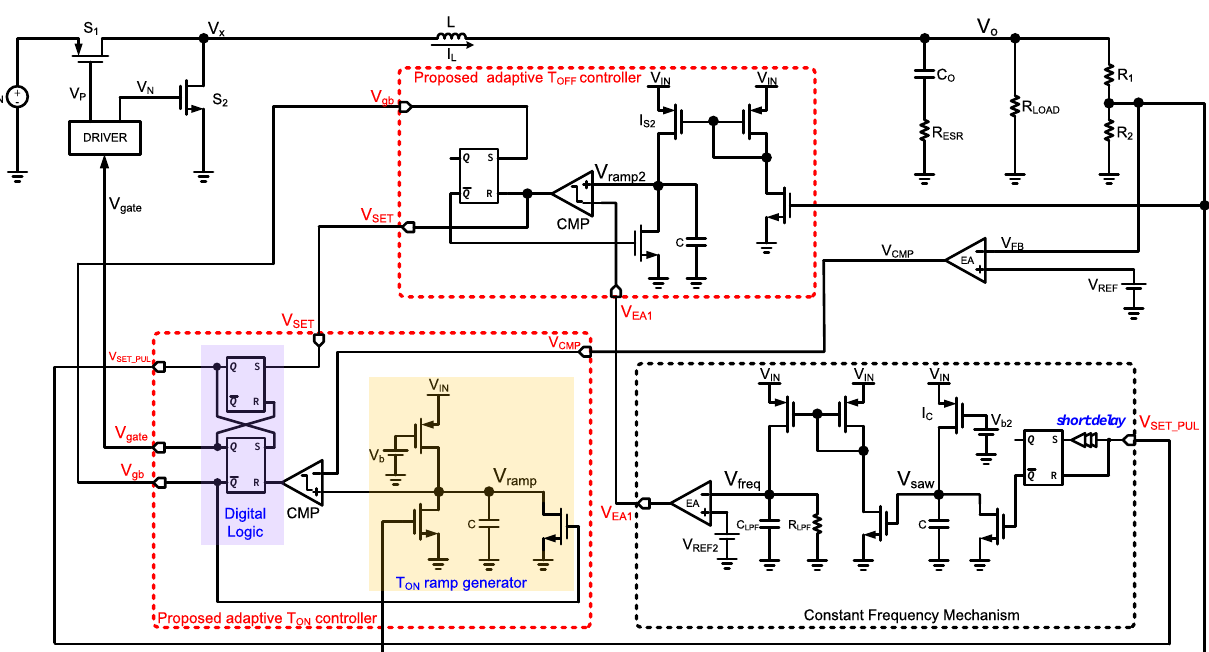
Figure 2. Control topology of the proposed converter.